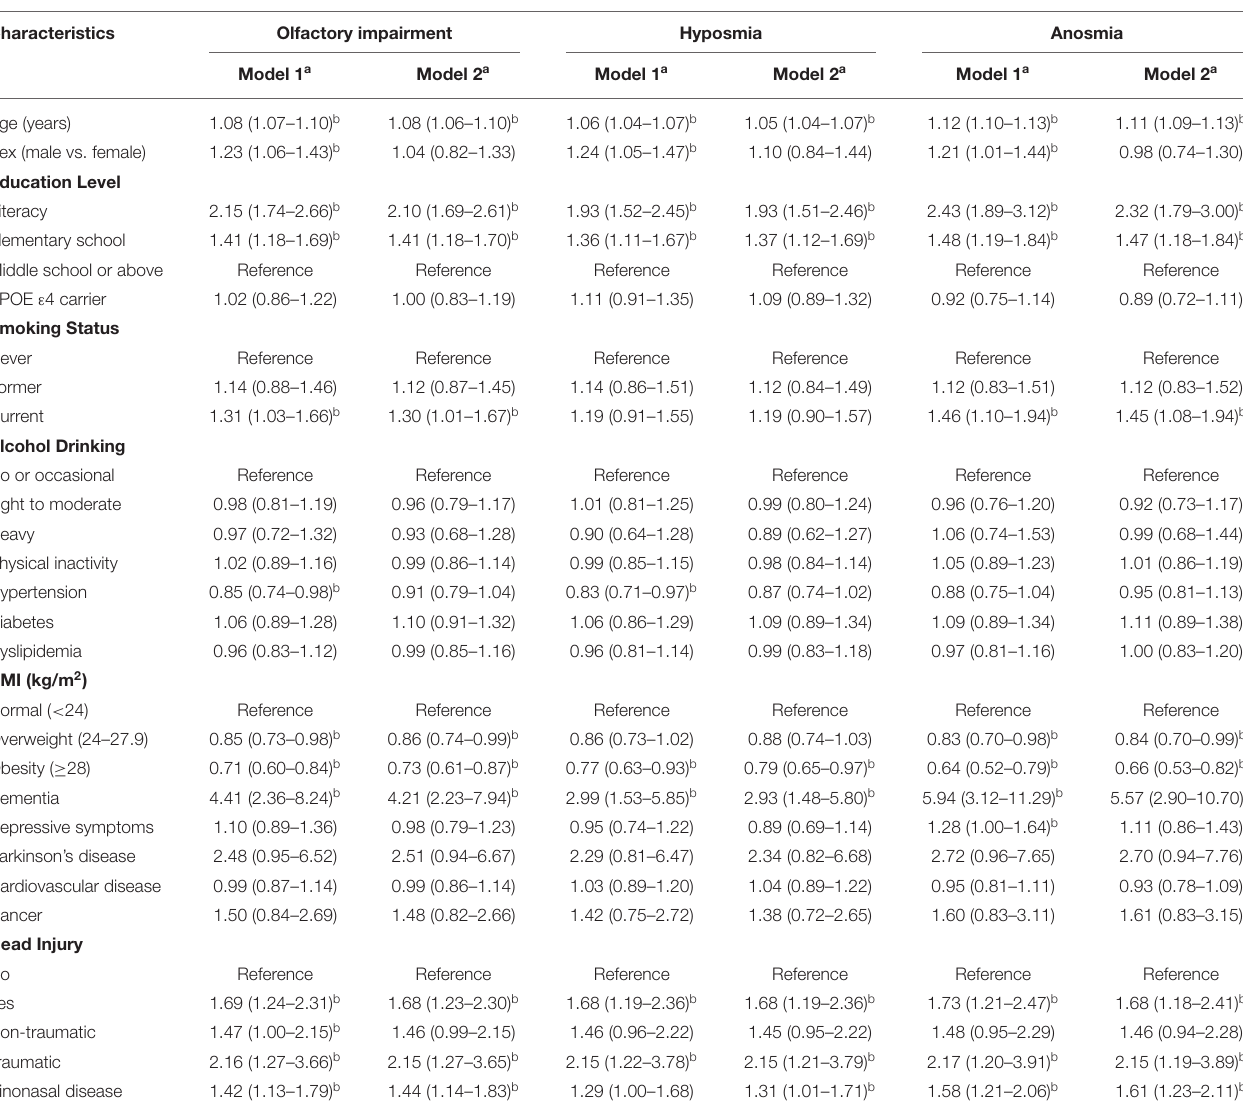
TABLE 2 | Demographic, lifestyle, and clinical correlates of olfactory impairment, hyposmia, and anosmia ( n =